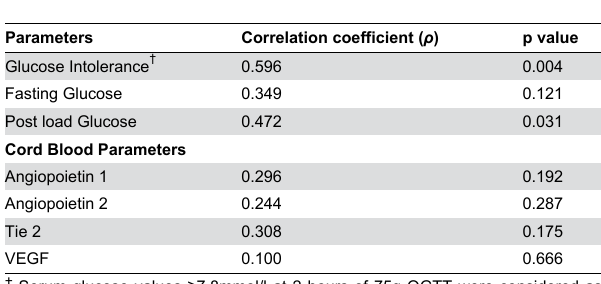
Table 3. Spearman's correlation analysis of Arginase activity with other parameters.